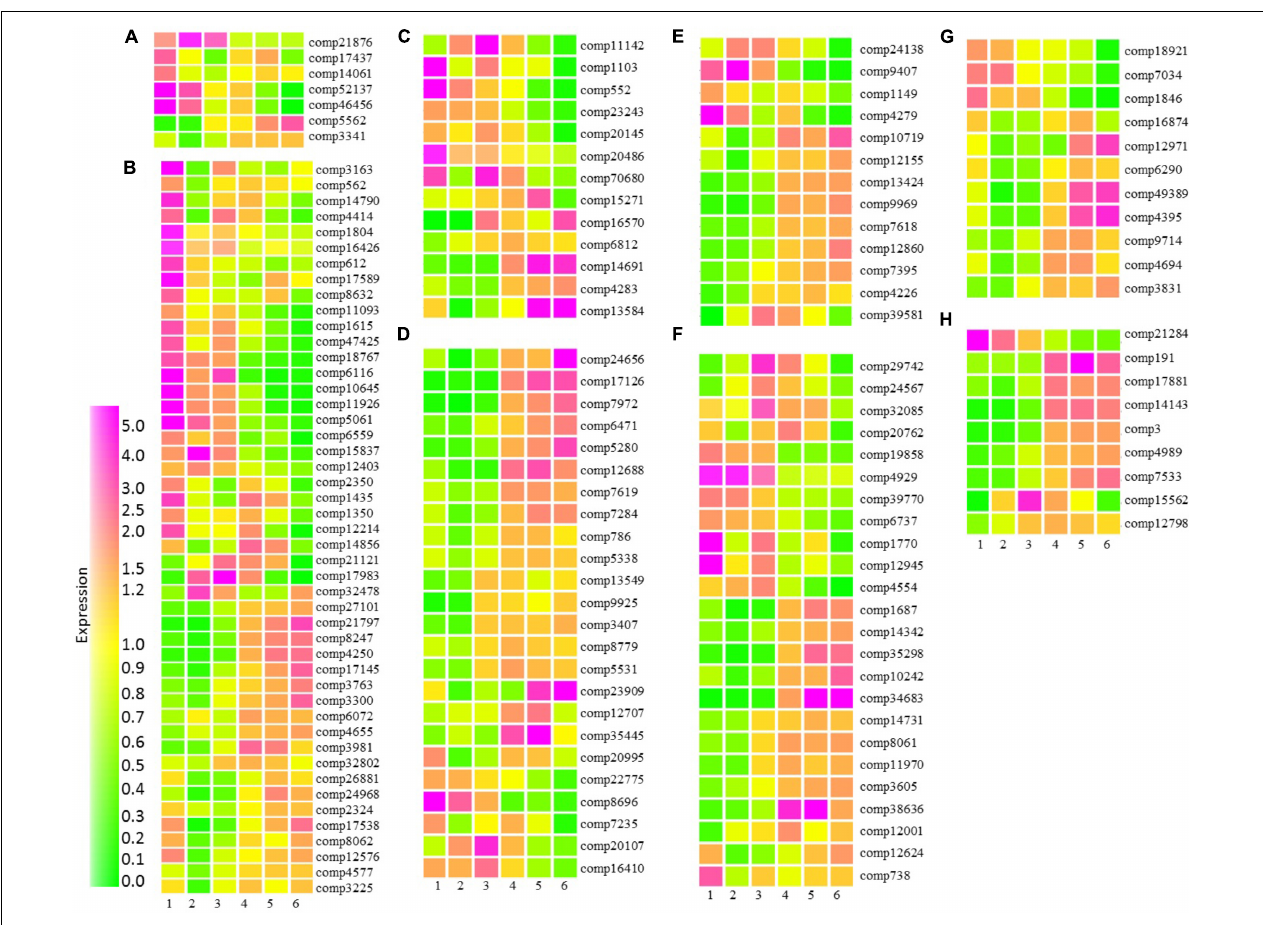
FIGURE 7 | Relative abundance of transcripts encoding proteins associated with hormone metabolism and signaling at six stages of blackcurrant fruit development. Transcript levels are expressed relative to the median level of the transcript across all 18 arrays according to the scale indicated. Transcripts shown are putatively associated with cytokinin (A) , auxin (B) , gibberellin (C) , ethylene (D) , abscisic acid (E) , brassinosteroid (F) , jasmonate (G) , and salicylate (H) metabolism or signaling. Transcripts are identified by their contig reference as indicated to the right of each